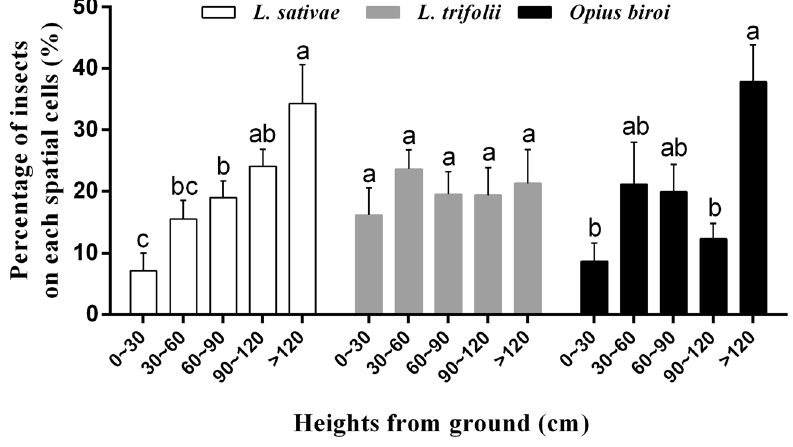
Figure 2. Distribution of Liriomyza sativae, L. trifolii and Opius biroi in each spatial cell (bars sharing the same letter indicate no significant differences were found at the 5% level using Turkey’s HSD tests).